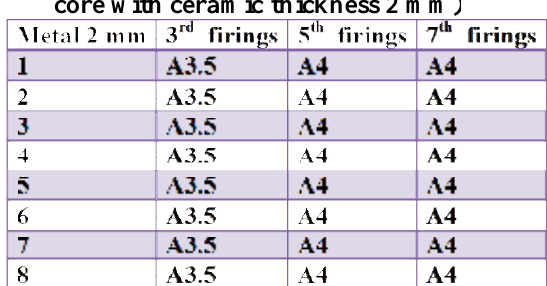
Table 9: Shade results of group C2